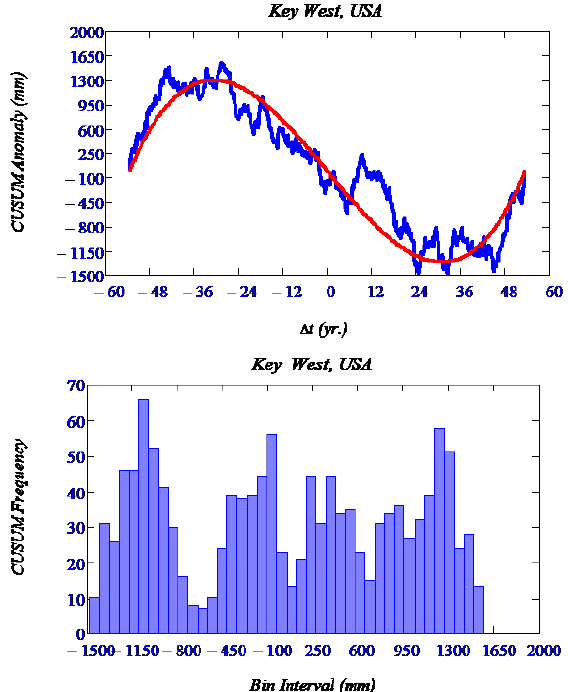
Fig. 5. Residuals and the estimated uniform acceleration’s CUSUM charts at Key West, USA, TG station (top). The histogram of the residuals compartmentalizes the residuals before and after the critical points and the inflection